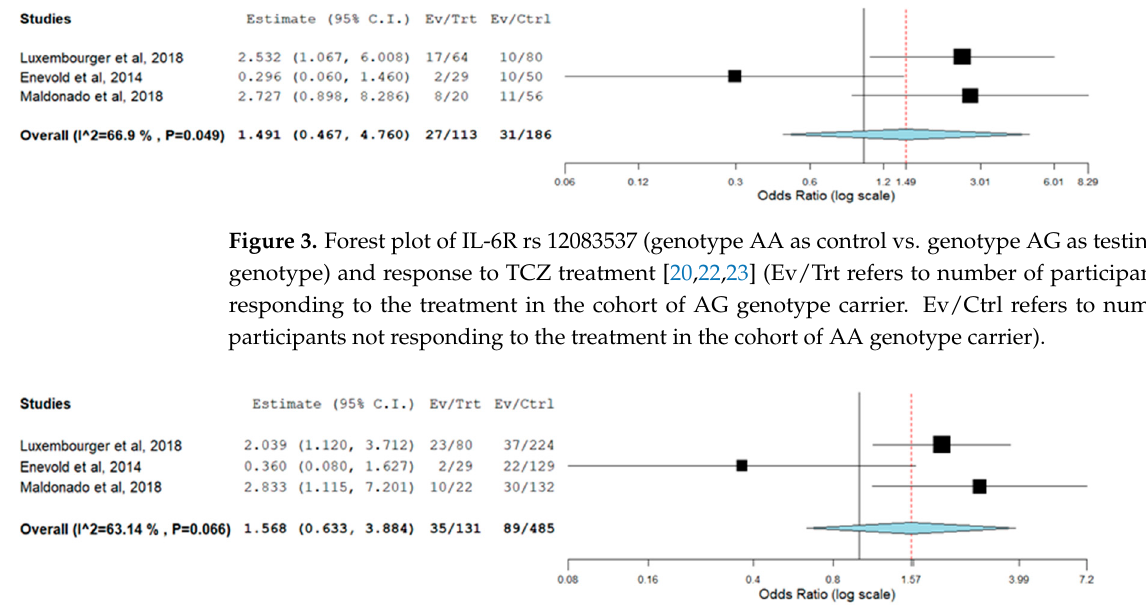
Figure 4. Forest plot of IL-6R rs 12083537 (allele A as control vs. allele G as risk allele) and response to TCZ treatment [20,22,23] (Ev/Trt refers to number of participants not responding to the treatment in the cohort of G allele carrier. Ev/Ctrl refers to number of participants not responding to the treatment in the cohort of A allele carrier).